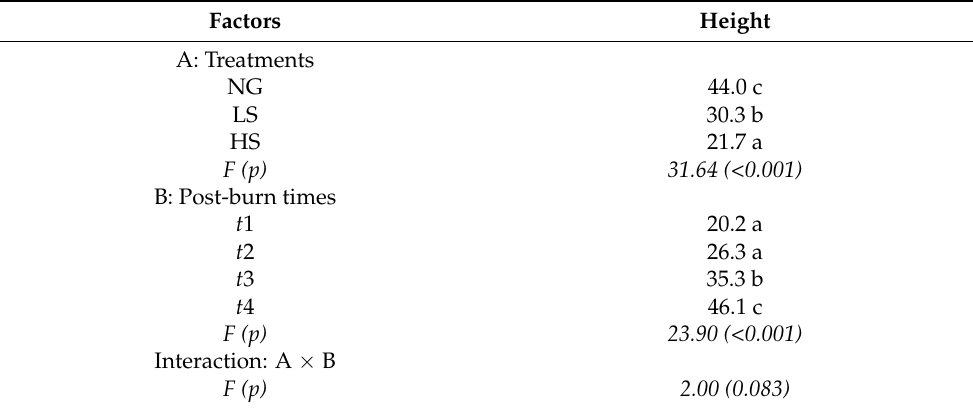
Table 3. Two-way ANOVAs for height (cm) of dominant plant species, where (A) grazing (NG = non-grazed, LS = low stocking rate, HS = high stocking rate) and (B) post-burn times ( t 1 . . . t 4) were the main analysis factors. Interactions A × B are also analysed. Species height from t 0 to t 4 is presented in Table S2.